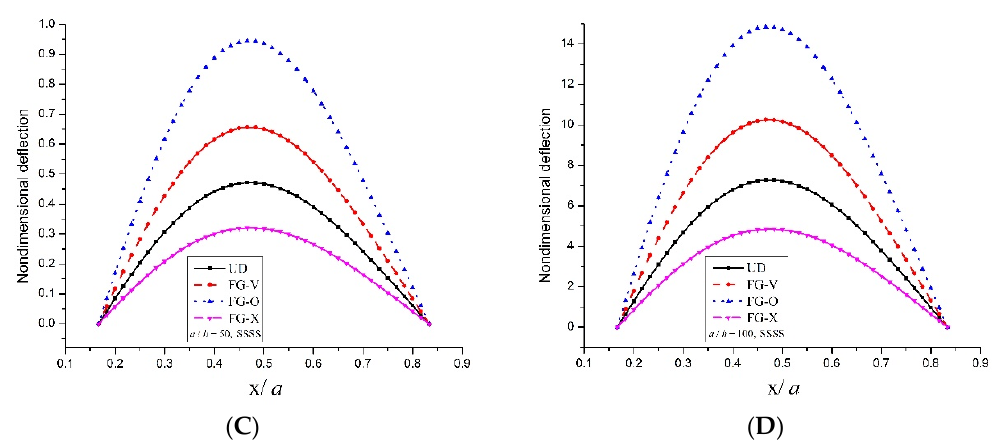
Figure 8. Non ‐ dimensional deflection of FG ‐ CNTRC skew plate along the length (y/b = 0.5) subjected to sin ‐ sin loading for ( A ) a/h = 10; ( B ) a/h = 20; ( C ) a/h = 50 and ( D ) a/h = 100. Figures 9 and 10 show the variation of non ‐ dimensional axial stress for FG ‐ CNTRC rhombic plate subjected to sin ‐ sin loading for simply supported and clamped boundary condition, respectively. The dimensionless value of axial stress decreases with an increase in the skew angle and same nature of variation in thickness coordinate was noticed for all values of skew angles.